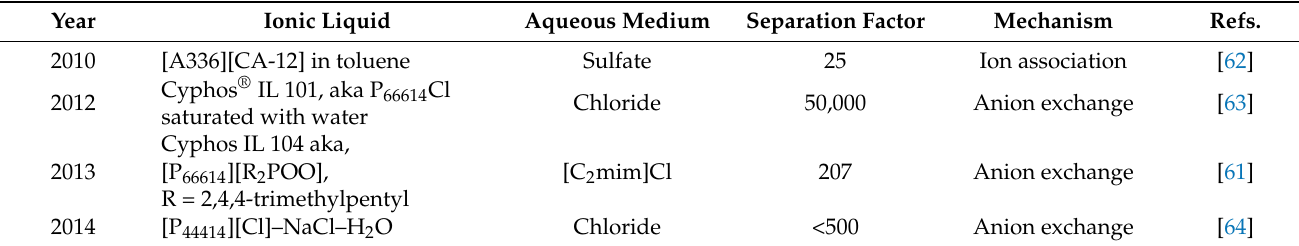
Table 4. Examples of IL used in Co/Ni